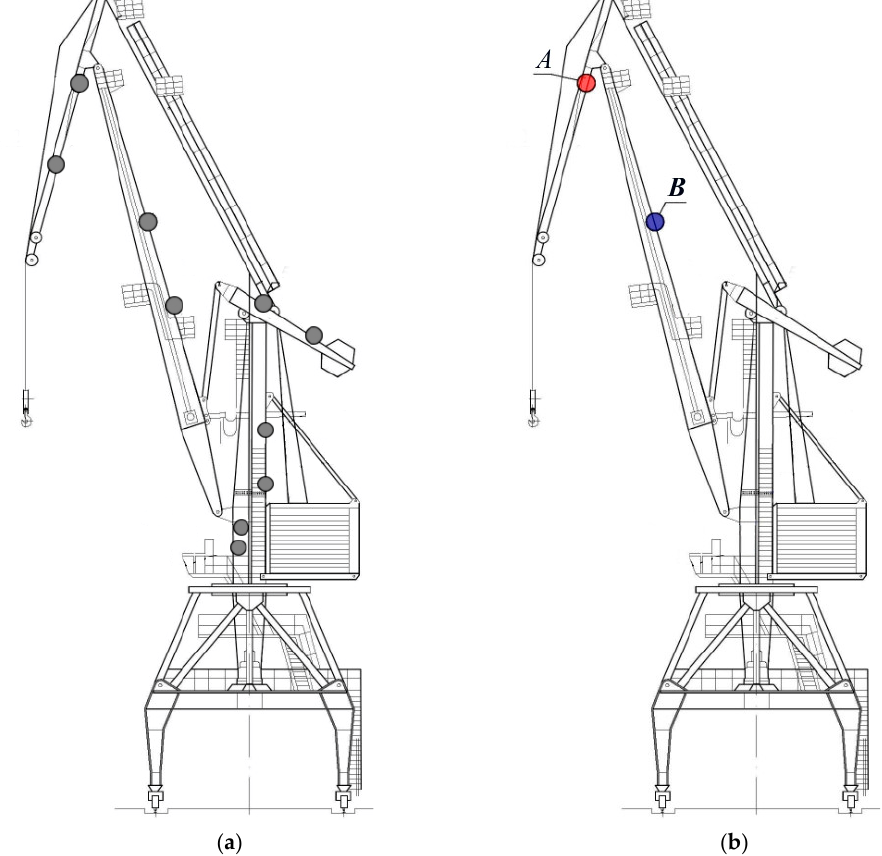
Figure 1. Schemes of a portal crane indicating the points for cyclic stress evaluation ( a ) and units chosen for present research ( b ): A –steel A, B –steel B. chosen for present research ( b ): A –steel A, B –steel B. The crane was operated under the action of cyclic loading and environmental